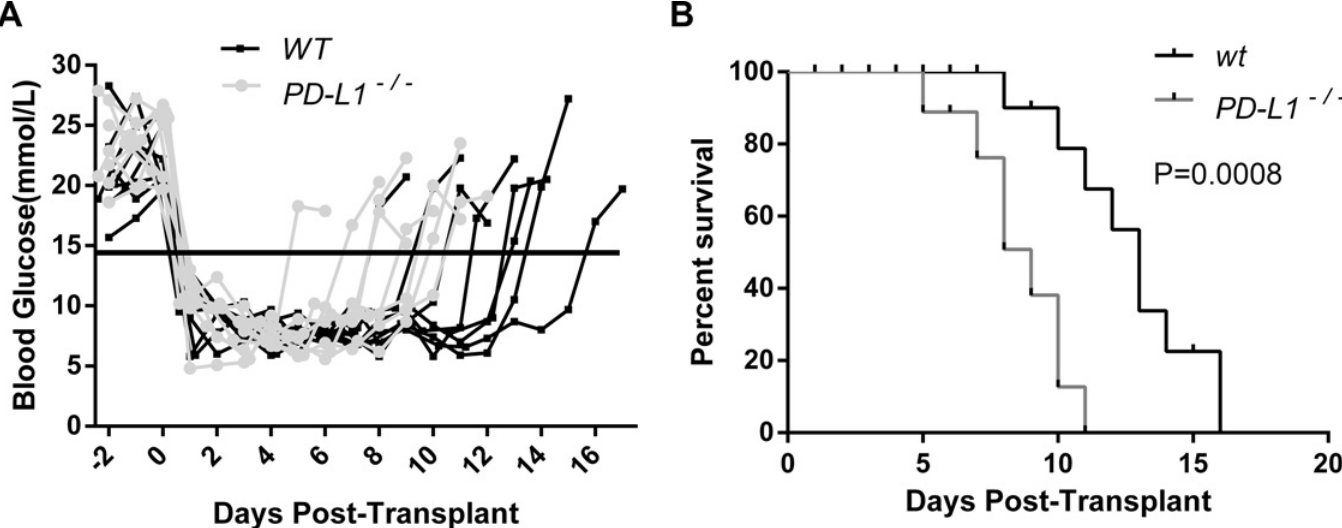
Fig 2. Survival of islet allografts from the donors of WT mice and PD L1-deficient mice. Blood glucose levels and islet graft survival in the recipients bearing islets from WT mice and PDL1- deficient mice are shown (N = 8). Diabetes was induced in BALB/c mice with STZ, followed by transplantation of four hundred islets isolated from WT or PDL1- deficient mice. The blood glucose levels are shown in Fig 2A in comparison with the glucose levels of the recipients transplanted with the islets from WT mice. Euglycemia was maintained for a shorter duration in the recipients bearing islets from PD-L1-deficient mice (Fig 2B). Graft survival was calculated by the Kaplan-Meier method and compared using a log-rank test (P = 0.0008). The results show that the survival time of the recipients transplanted with islets from PD-L1-deficient mice was clearly shorter compared with that of the recipients bearing islets from WT